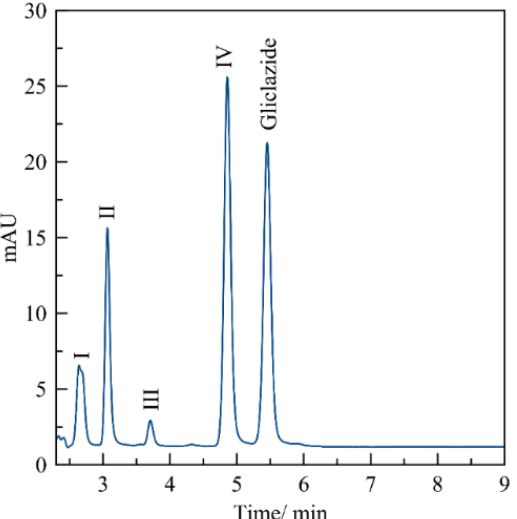
− 1 after 3 h at 80 ◦ C. Conditions: stationary